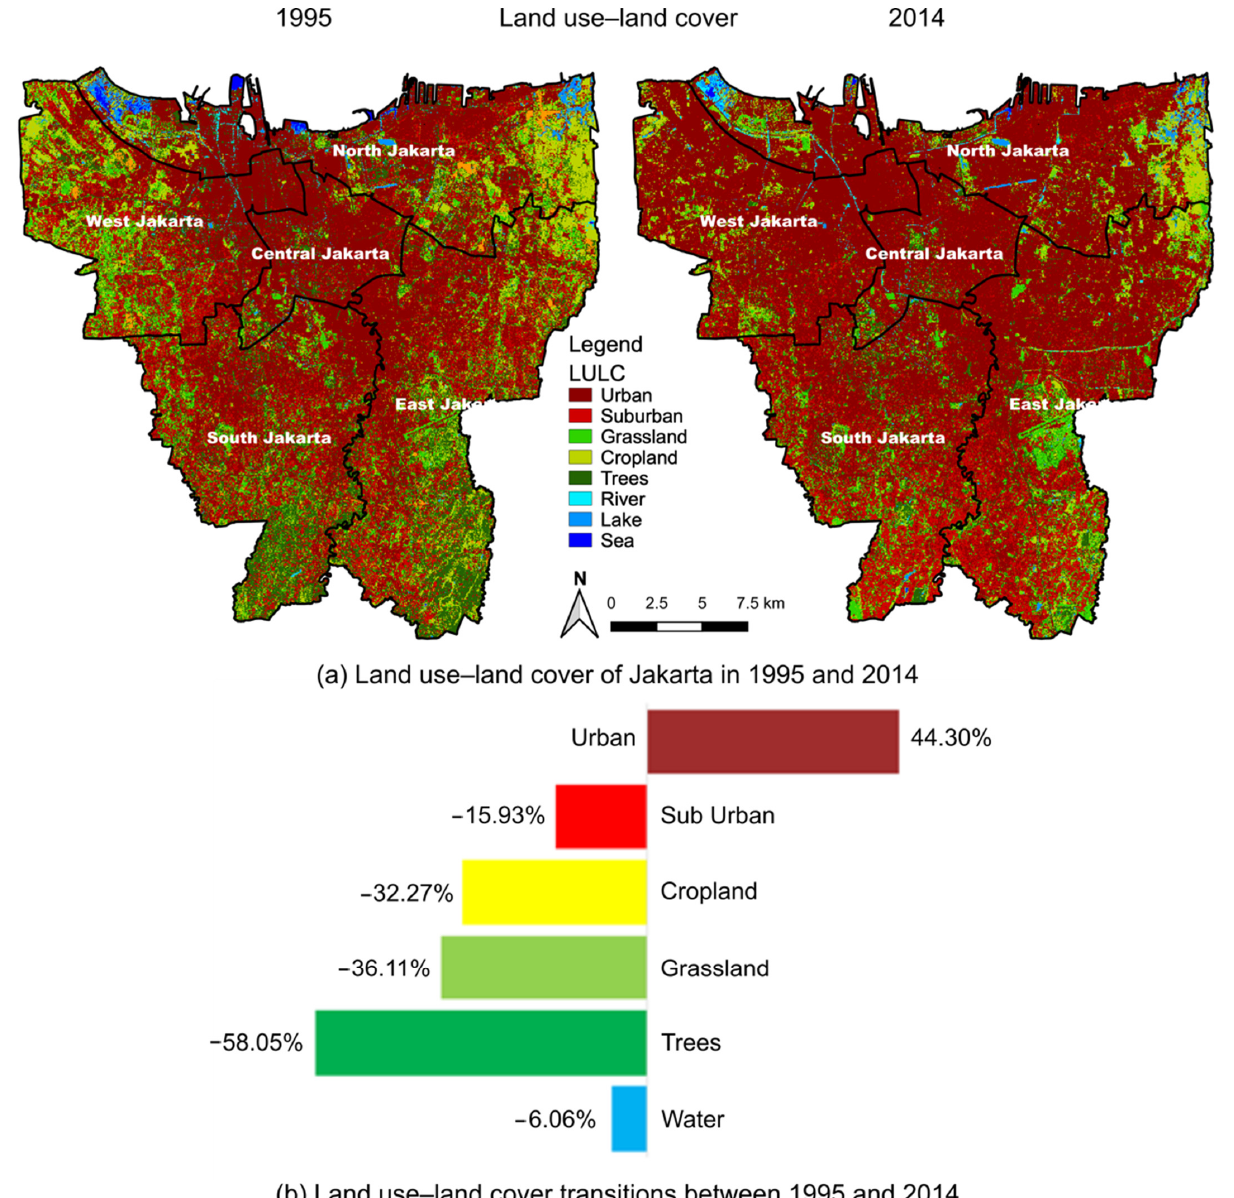
Figure 3. Land use–land cover change from 1995 to